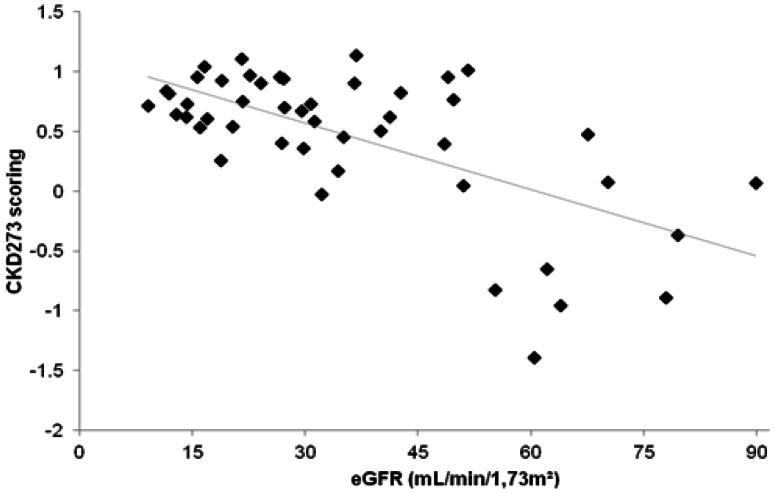
CKD273 scoring and eGFR values in the patients included in the study.The patients treated by dialysis are not included in the figure as their eGFR could not be calculated by the serum creatinine level. Linear Regression equation, y = −0.019x +1.12; R2 = 0.40; p<0.001.